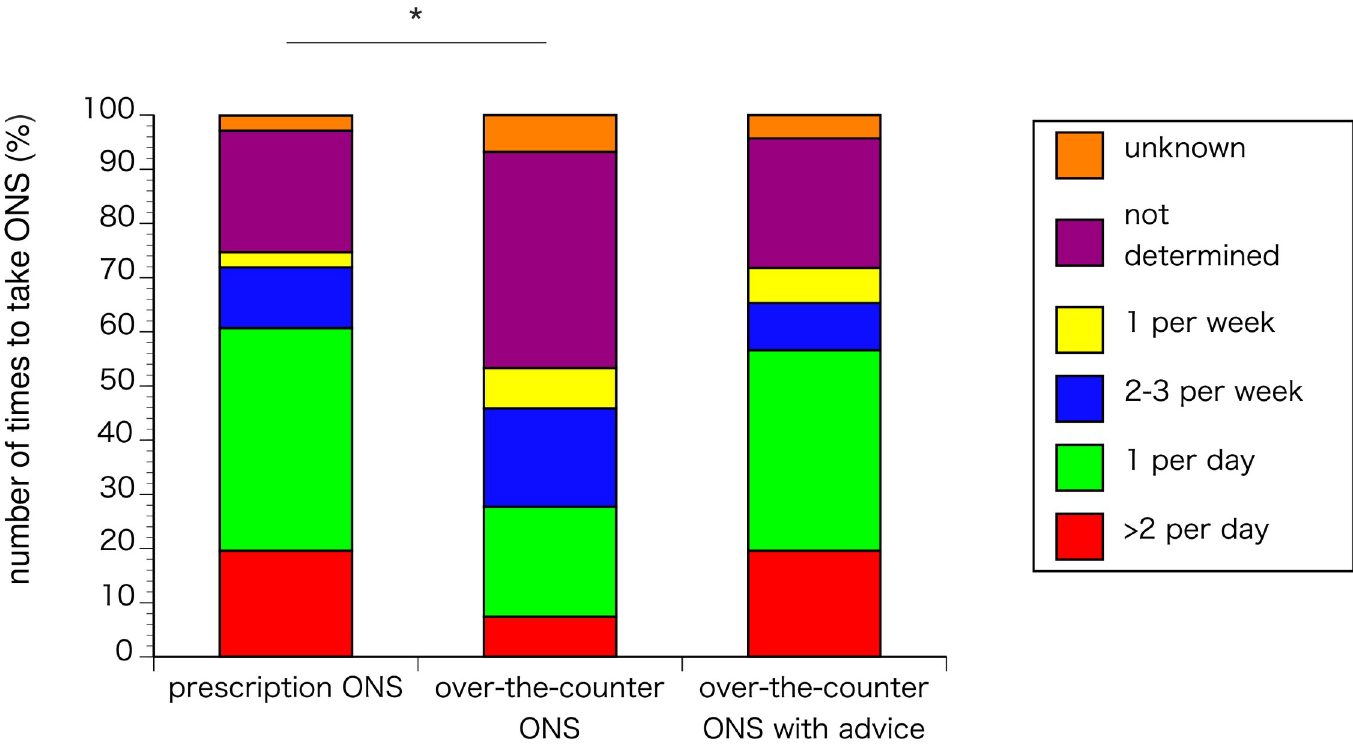
Fig 3. Number of times to take ONS. � p < 0.0001.